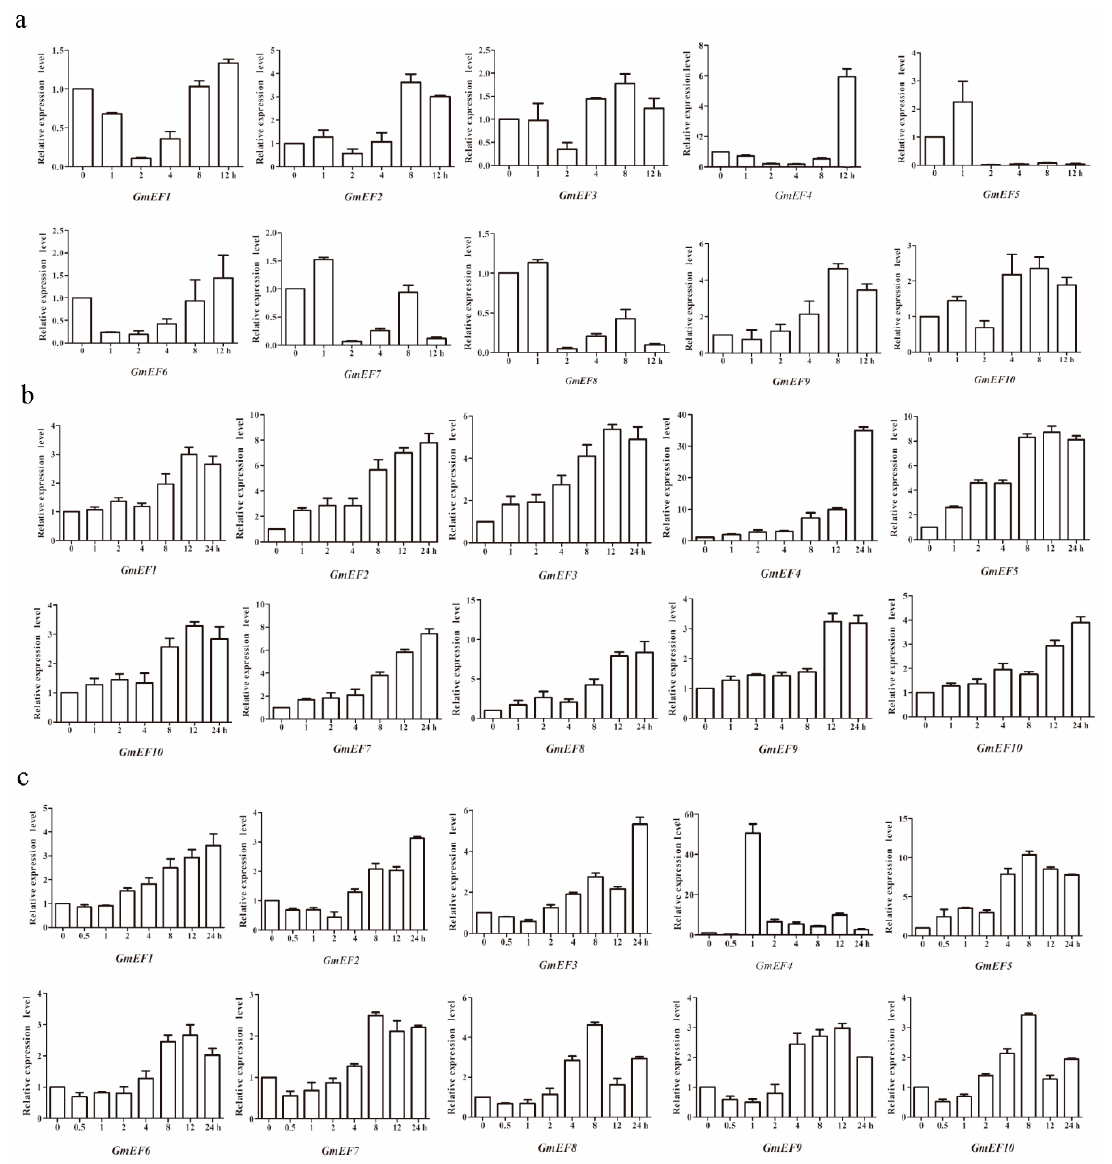
Figure 5. Expression patterns of soybean EF1 α s under drought stress, salt stress, and abscisic acid (ABA) treatment. ( a ) Expression levels of the 10 soybean EF1 α genes under drought stress, as measured using qRT-PCR. Drought treatment was applied for 0, 1, 2, 4, 8, and 12 h. ( b ) Expression levels of 10 soybean EF1 α genes under NaCl treatment for 0, 1, 2, 4, 8, 12, and 24 h. ( c ) Expression levels of the 10 soybean EF1 α genes under ABA treatment, as measured using qRT-PCR. ABA treatment was applied for 0, 0.5, 1, 2, 4, 8, 12, and 24 h. The vertical coordinates are fold changes, and the horizontal ordinates are treatment times. The actin gene was used as an internal reference. The data are shown as means of three biology repeats ± SD.